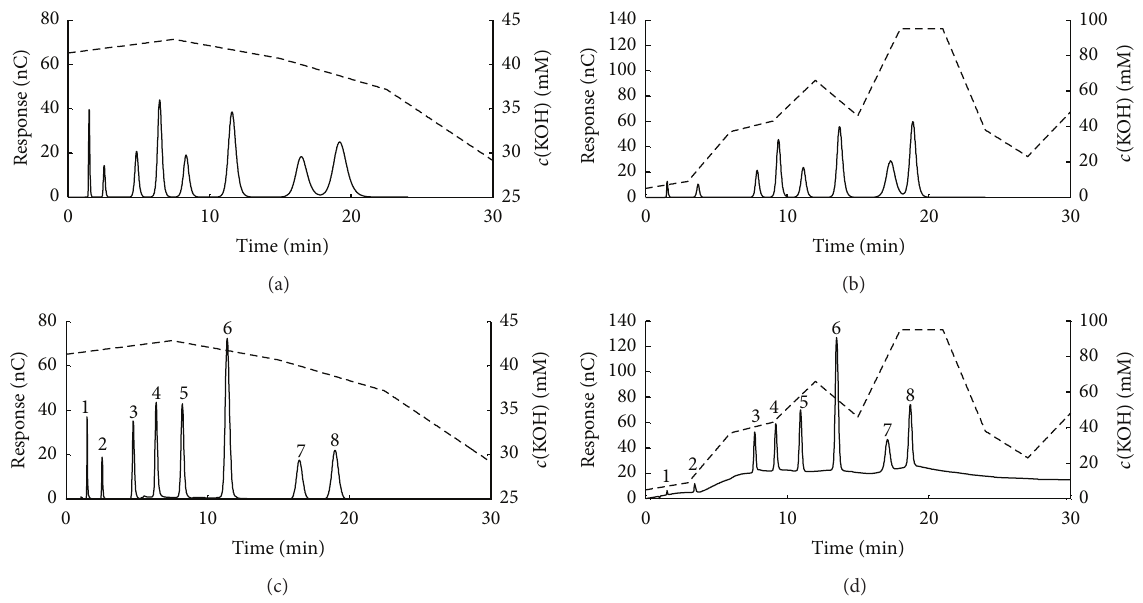
Figure5:Comparisonofexperimentalandpredictedchromatogramsobtainedwithoptimalgradientprofile:(a)predictedoptimalseparation by simplex algorithm, (b) predicted optimal separation by genetic algorithm, (c) real chromatogram corresponding to simplex optimization, and (d) real chromatogram corresponding to genetic algorithm. Dashed lines indicate the calculated optimal gradients. Analyzed sugars are marked according to elution order: (1) arabitol, (2) fucose, (3) N-acetyl-D-glucosamine, (4) fructose, (5) melibiose, (6) lactulose, (7) raffinose, and (8)